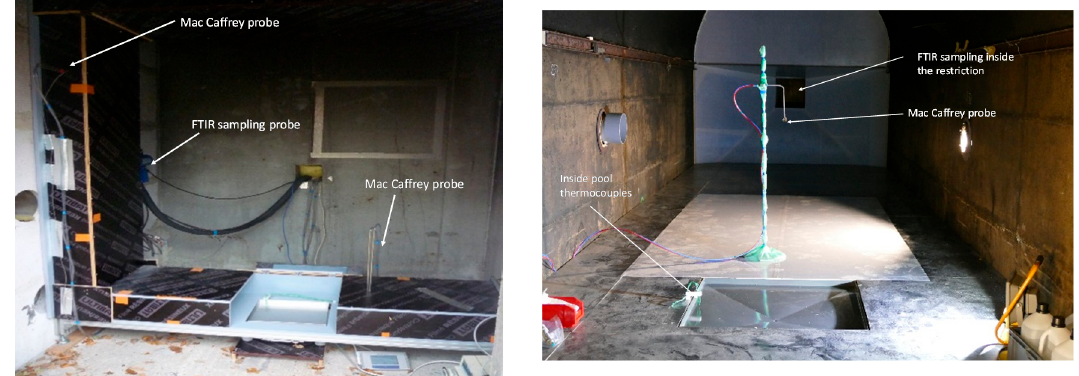
Figure2. Pictureofthepoolphotographyandinstrumentationforsmall( left )andmedium( right Figure 2. Picture of the pool photography and instrumentation for small ( left ) and medium ( right ) scales.